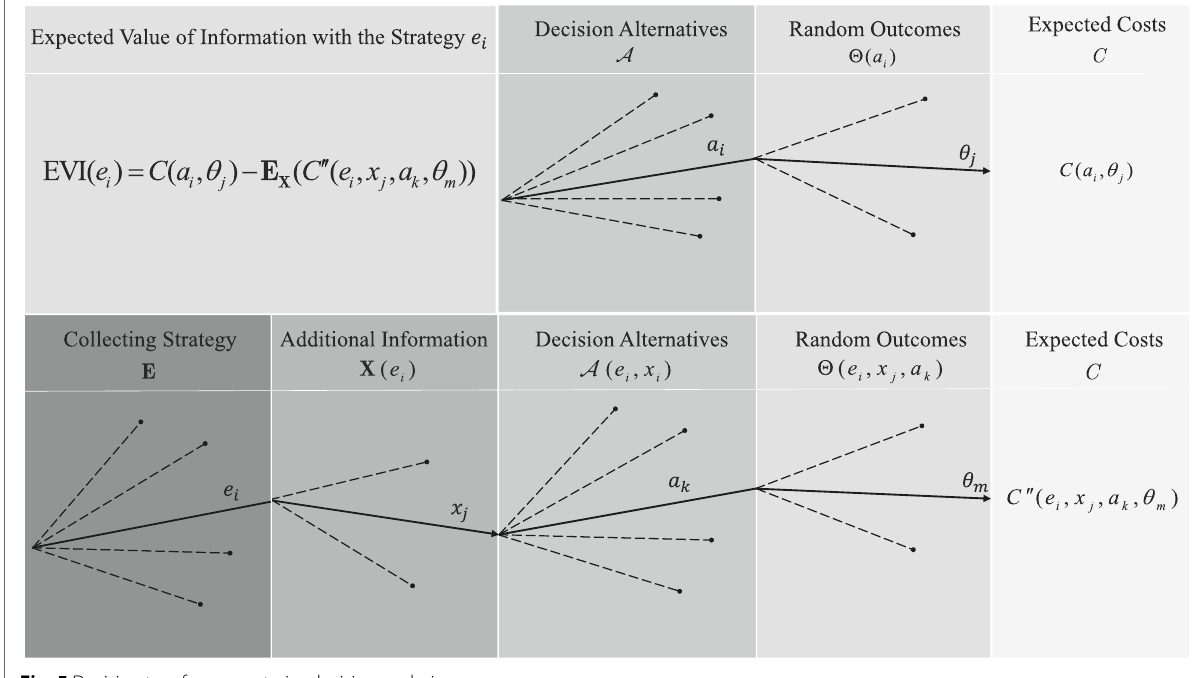
Fig. 5 Decision tree for preposterior decision